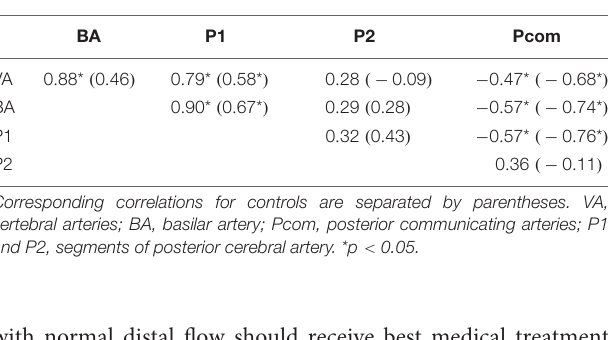
TABLE 4 | Matrix of correlation coefficients ( r ) in